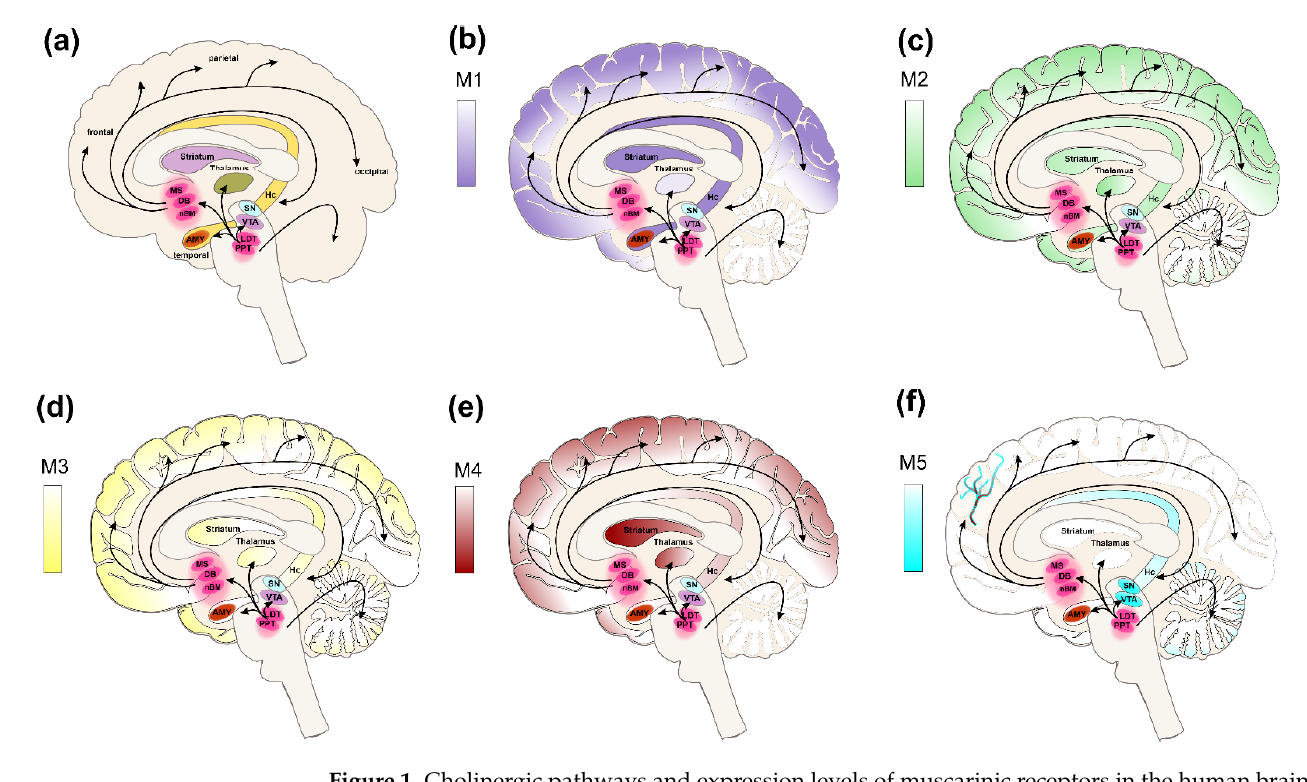
Figure 1. Cholinergic pathways and expression levels of muscarinic receptors in the human brain. ( a ) The cholinergic inputs to cortical and subcortical structures from the basal forebrain projections, including medial septum (MS), diagonal band of Broca (DB), and nucleus basalis magnocellularis (nBM) with projections (black arrows) to the neocortex (frontal, parietal, occipital), amygdala (AMY), and hippocampus (Hc). The brainstem cholinergic projections from the pedunculopontine nucleus (PPN) and laterodorsal tegmentum (LDT) to the thalamus and the structures of the basal forebrain. The distribution of individual muscarinic receptors subtypes ( b ) M 1 (purple), ( c ) M 2 (green), ( d ) M 3 (yellow), ( e ) M 4 (red), ( f ) M 5 (cyan) with expression levels indicated by colour gradients. According to [45]. Table 1. Signalling, expression sites, and implications in CNS disorders.